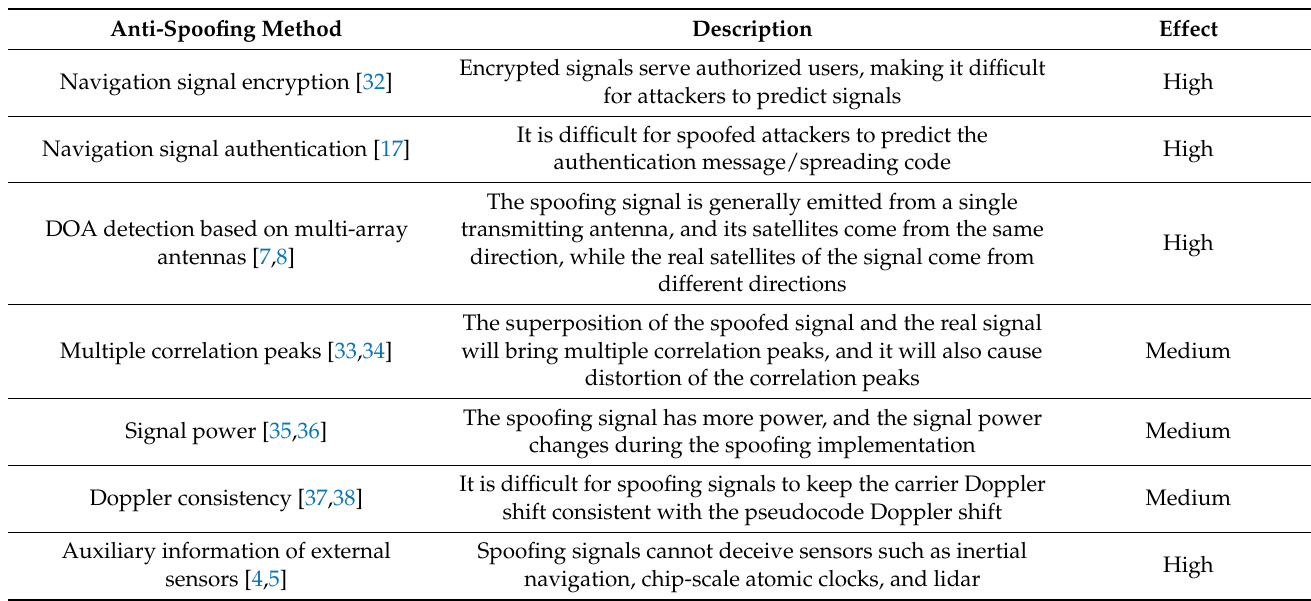
Table 3. Comparison of common anti-spoofing algorithms.